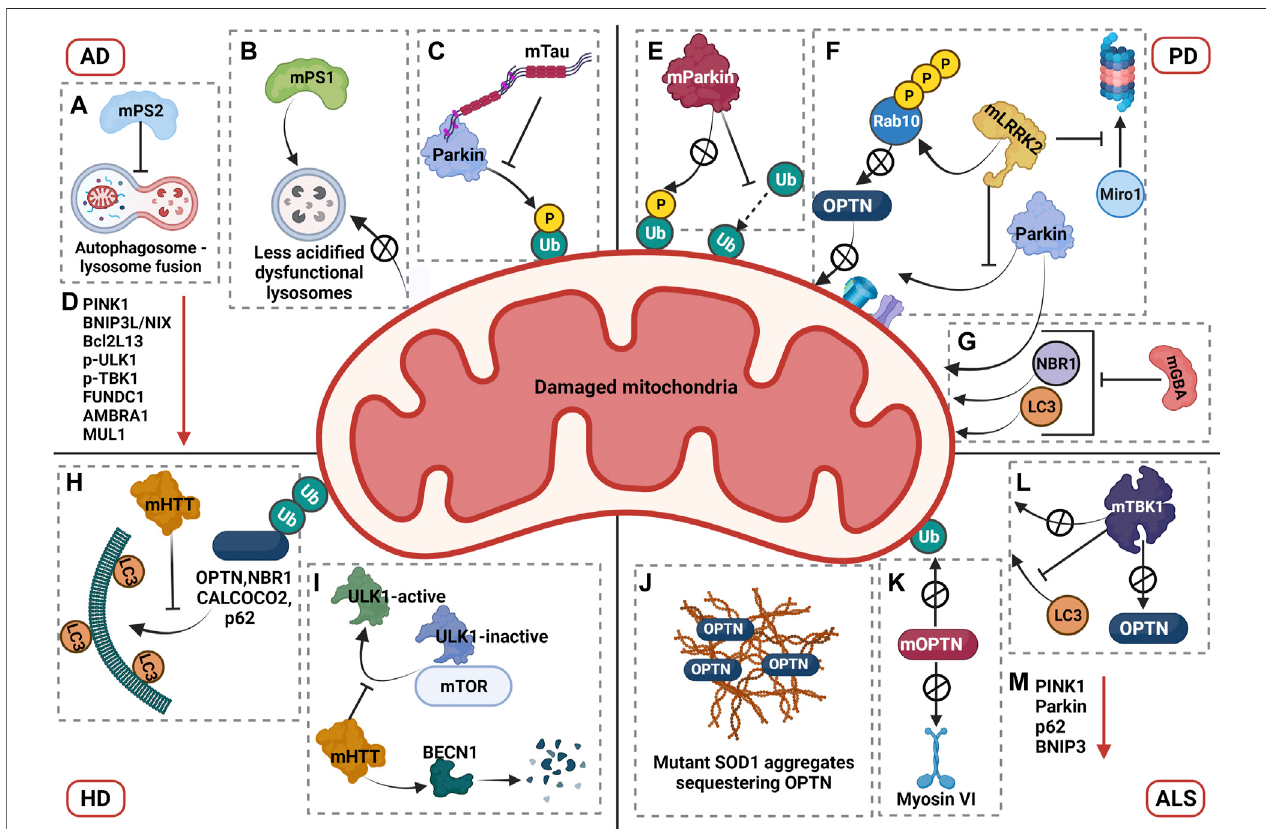
FIGURE 3 | Mechanisms of mitophagy dysregulation in neurodegenerative disorders. AD : (A) AD associated mutations in presenilin 2 (mPS2) blocks mitophagosometolysosomefusionbyaffectingtheRab7recruitment, leadingtoaccumulation ofmitophagosomes. (B) ADassociatedmutationsinpresenilin1(mPS1) gene decrease the lysosomal acidi fi cation by impairing the transport of V-ATPase thereby blocking the clearance ofdamaged mitochondria. (C) Pathogenic Tau (mTau) interacts with Parkin with its projection domain, inhibiting the recruitment of Parkin to damaged mitochondria. (D) AD models also show down regulation of mitophagyassociatedproteinsPINK1,BNIP3L/NIX,Bcl2L13,p-ULK1,p-TBK1,FUNDC1,AMBRA1,andMUL1(Theredarrowinthe fi gurerepresentsdownregulation). PD : (E) PD associated mutations affect the role of Parkin in two ways. Mutations either block Parkin recruitment to damaged mitochondria or impair the ubiquitination capacityofParkin,bothofwhichimpairsthemitophagypathway. (F) PDassociatedmutationsinLRRK2impairmitophagypathwayatdifferentstages.Basedonspeci fi c mutations, LRRK2 hyperphosphorylates Rab10, which prevents its interaction with OPTN thereby blocking its recruitment to damaged mitochondria. Mutant LRRK2 has been shown to prevent the interaction of Parkin with OMM proteins. Mutant LRRK2 also inhibits Miro1 degradation, an essential step for arrest of damaged mitochondria, further impairing the pathway. (G) PD associated mutations in GBA inhibit recruitment of Parkin, NBR1 and LC3 to the damaged mitochondria. HD : Dysregulation ofmitophagy pathway bymutant HTT(mHTT) involves multiple mechanisms. (H) mHTT blocks the recruitmentofOPTN,NBR1,CALCOCO2 and p62. (I) mHTT stabilizes the interaction of inactive ULK1 to mTOR, thereby impairing the formation of autophagy initiation complex. mHTT promotes degradation of Beclin1, whichalsopreventstheformationofautophagyinitiationcomplex. ALS : (J) Mutant SOD1(mSOD1)aggregatessequesterOPTN preventingitsrecruitmenttodamaged mitochondria. (K) ALS associated mutations in OPTN (mOPTN) blocks its recruitment to damaged mitochondria and also impairs its interaction with myosin VI, thereby restricting the localization of mutant OPTN in cytoplasm. (L) ALS linked mutations in TBK1 (mTBK1) blocks its recruitment to damaged mitochondria, impairs its interaction with OPTN and impedes the recruitment of LC3 to damaged mitochondria. (M) In addition, mitophagy related proteins PINK1, Parkin, p62, and BNIP3 are downregulated in ALS (The red arrow in the fi gure represents